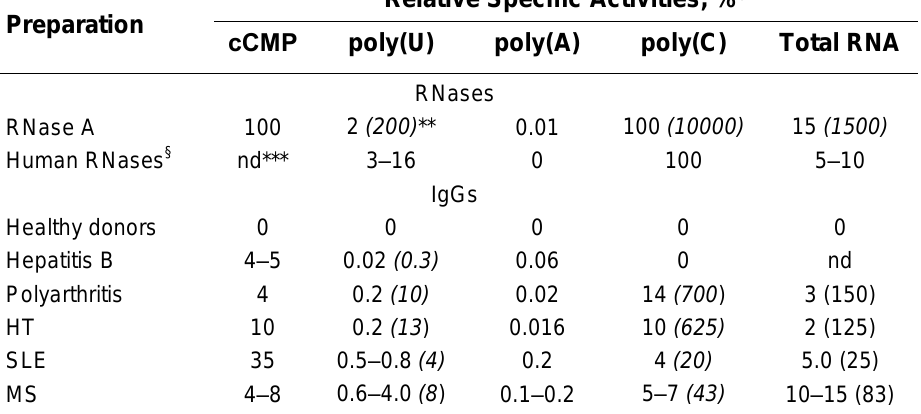
Relative Specific Activities of pIgGs from the Sera of Patients with Different ADs in Comparison with those for Pancreatic RNase A and RNases from Human Blood in the Hydrolysis of Various Ribopolynucleotides and сycloСМР [29,122,29,130,143] Relative Specific Activities, Preparation